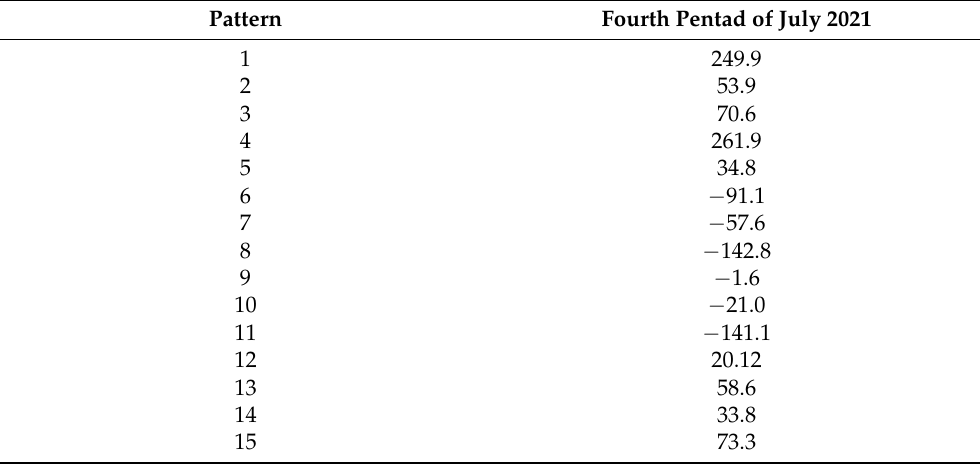
Table 2. Projection coefficient of the fourth pentad of July 2021 predicted by pentad DSDM in the predicting period (initial pentad: last pentad of June